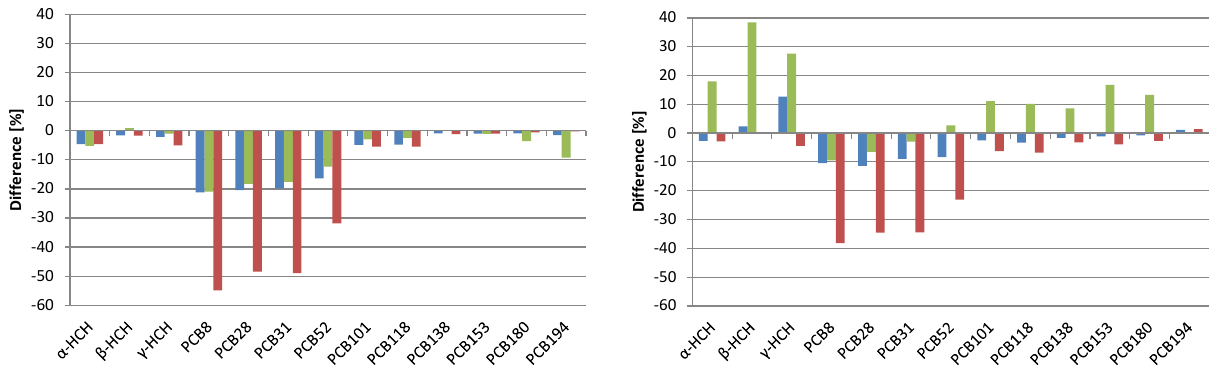
Figure 1. Difference in total mass between the 1990s and the 2090s calculated from the linear trend of the difference in annual averages compared to the average mass in 1999 in the entire model domain (left) and in the Arctic, defined as the area north of the Arctic Circle (66.5 ◦ N) (right), for the ES scenario (blue), the E scenario (green) and the S scenario